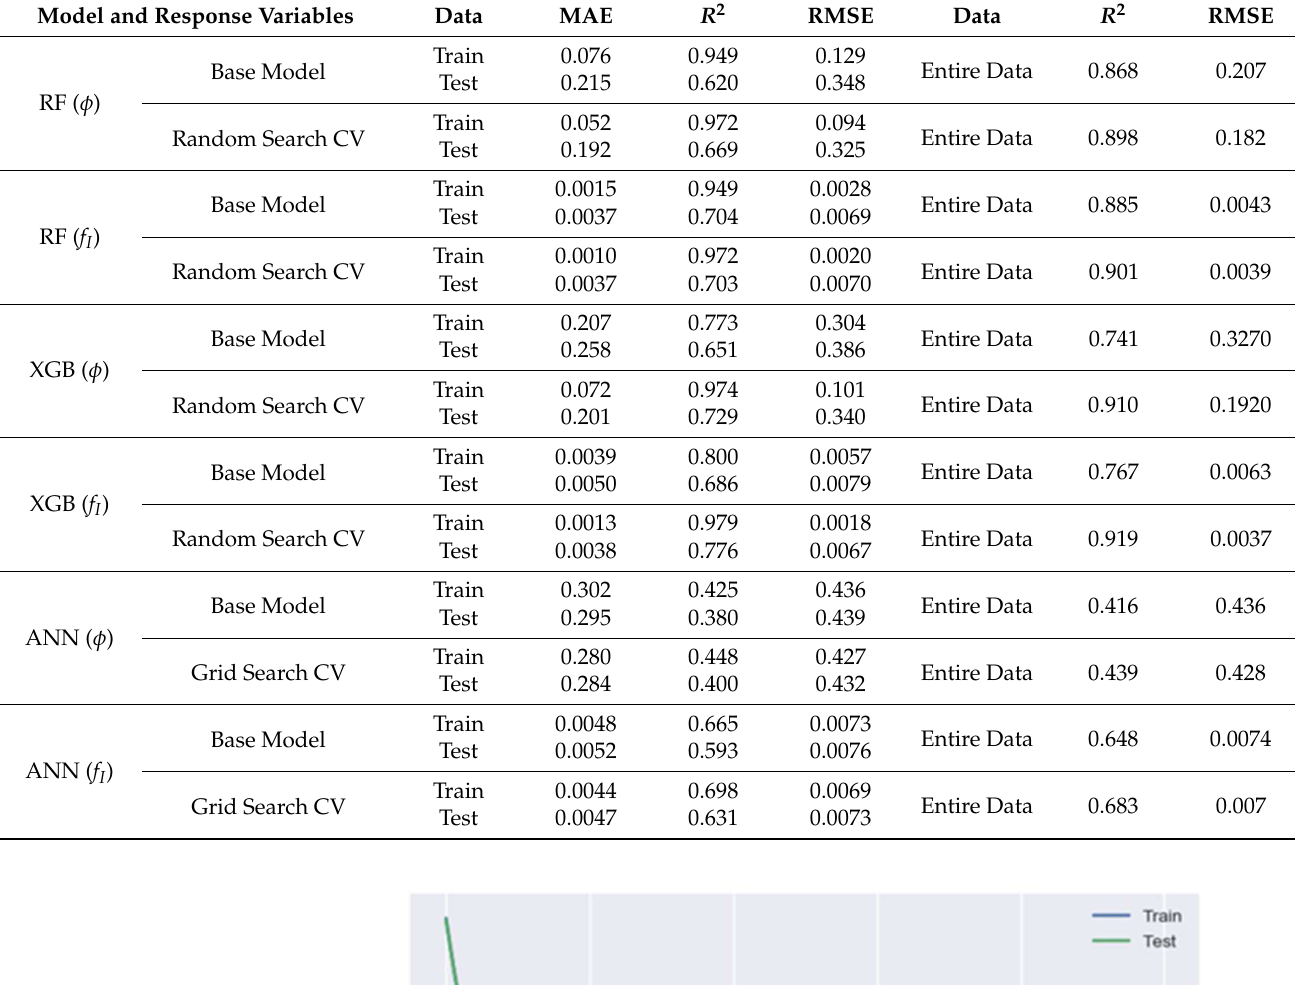
Table 1. Comparison of the accuracy metric for different machine learning models.